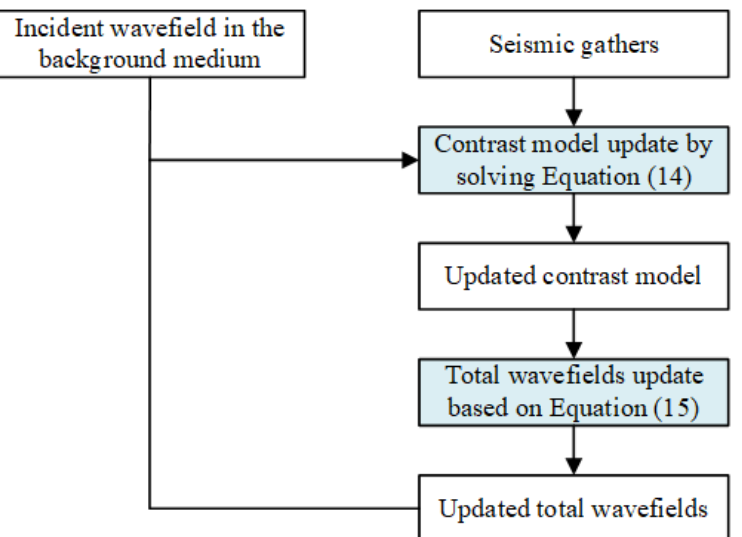
Figure 1. Workflow of the wave-equation-based inversion method.